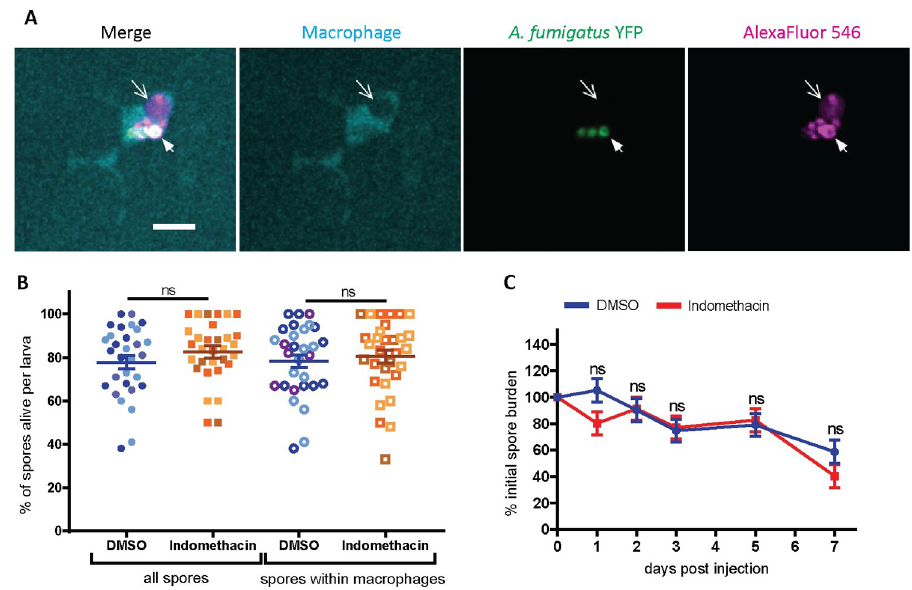
Fig 4. Cyclooxygenase inhibition does not affect spore killing. (A, B) Macrophage-labeled larvae Tg(mfap4 : mTurquoise2) were injected with YFP-expressing A . fumigatus TBK1.1 (Af293) spores coated with AlexaFluor 546 at 2 dpf, exposed to 10 μ M indomethacin or DMSO vehicle control, and imaged at 2 dpi. (A) Representative images showing live (white arrow) and dead (open arrow) spores within a macrophage. Scale bar = 10 μ m. (B) The percentage of live spores in the hindbrain, and specifically within macrophages, per larvae. Each data point represents an individual larvae, color-coded by replicate (indomethacin n = 31, DMSO n = 30). Bars represent pooled emmeans ± SEM from three independent replicates, P values calculated by ANOVA. (C) Wild-type larvae were injected with TBK1.1 (Af293) spores at 2 dpf, exposed to 10 μ M indomethacin or DMSO vehicle control, and fungal burden was quantified by homogenizing and plating individual larvae for CFUs at multiple days post injection. Eight larvae per condition, per dpi, per replicate were quantified, and the number of CFUs at each dpi is represented as a percentage of the initial spore burden. Bars represent pooled emmeans ± SEM from three individual replicates, P values calculated by ANOVA. Average injection CFUs: 27. Non-normalized raw CFU data is presented in S5 Fig.